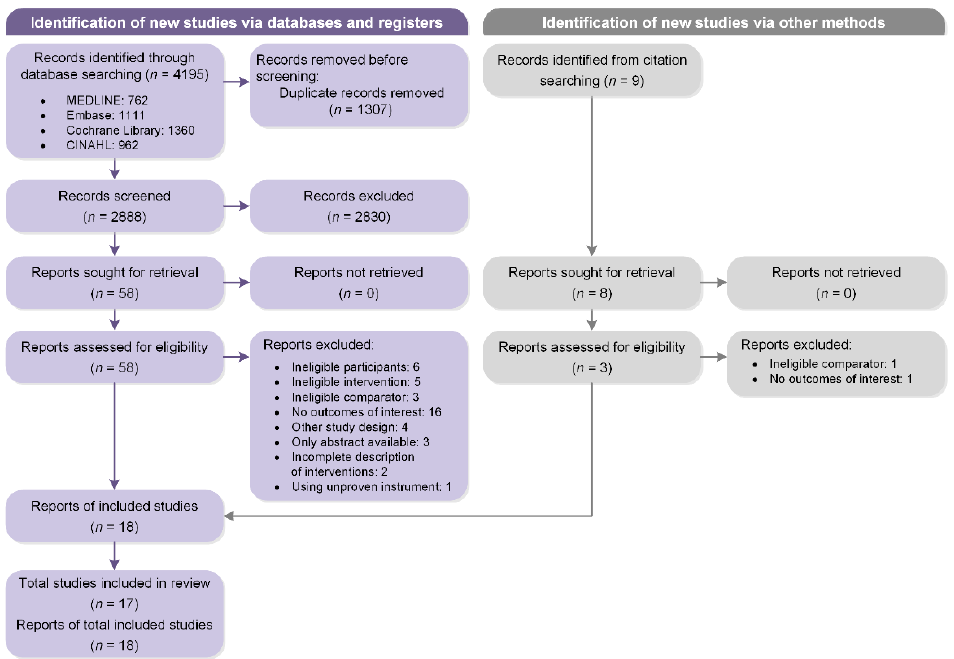
Figure 1. Flow diagram of the study selection process according to PRISMA guidelines.